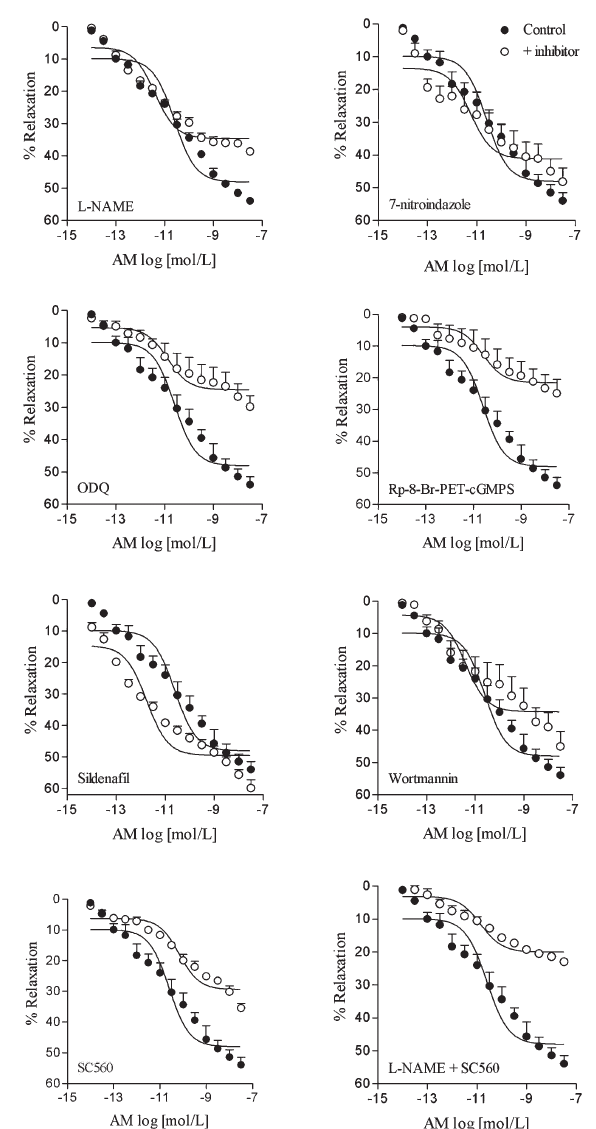
Figure 6. Relaxation responses induced by adrenomedullin (AM) on rat cavernosal smooth muscle strips pre-contracted with phenylephrine. The concentration-response curves were obtained in the absence (control) or after incubation for 30 min with the following drugs: 100 m M L-NAME, 100 m M 7-nitroinda- zole, 1 m M ODQ, 3 m M Rp-8-Br-PET-cGMPS, 10 m M